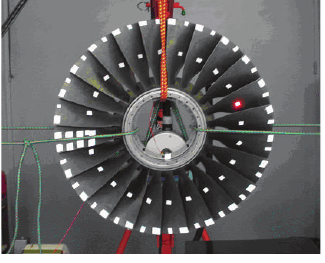
Figure 5: Excitation and force measurement.